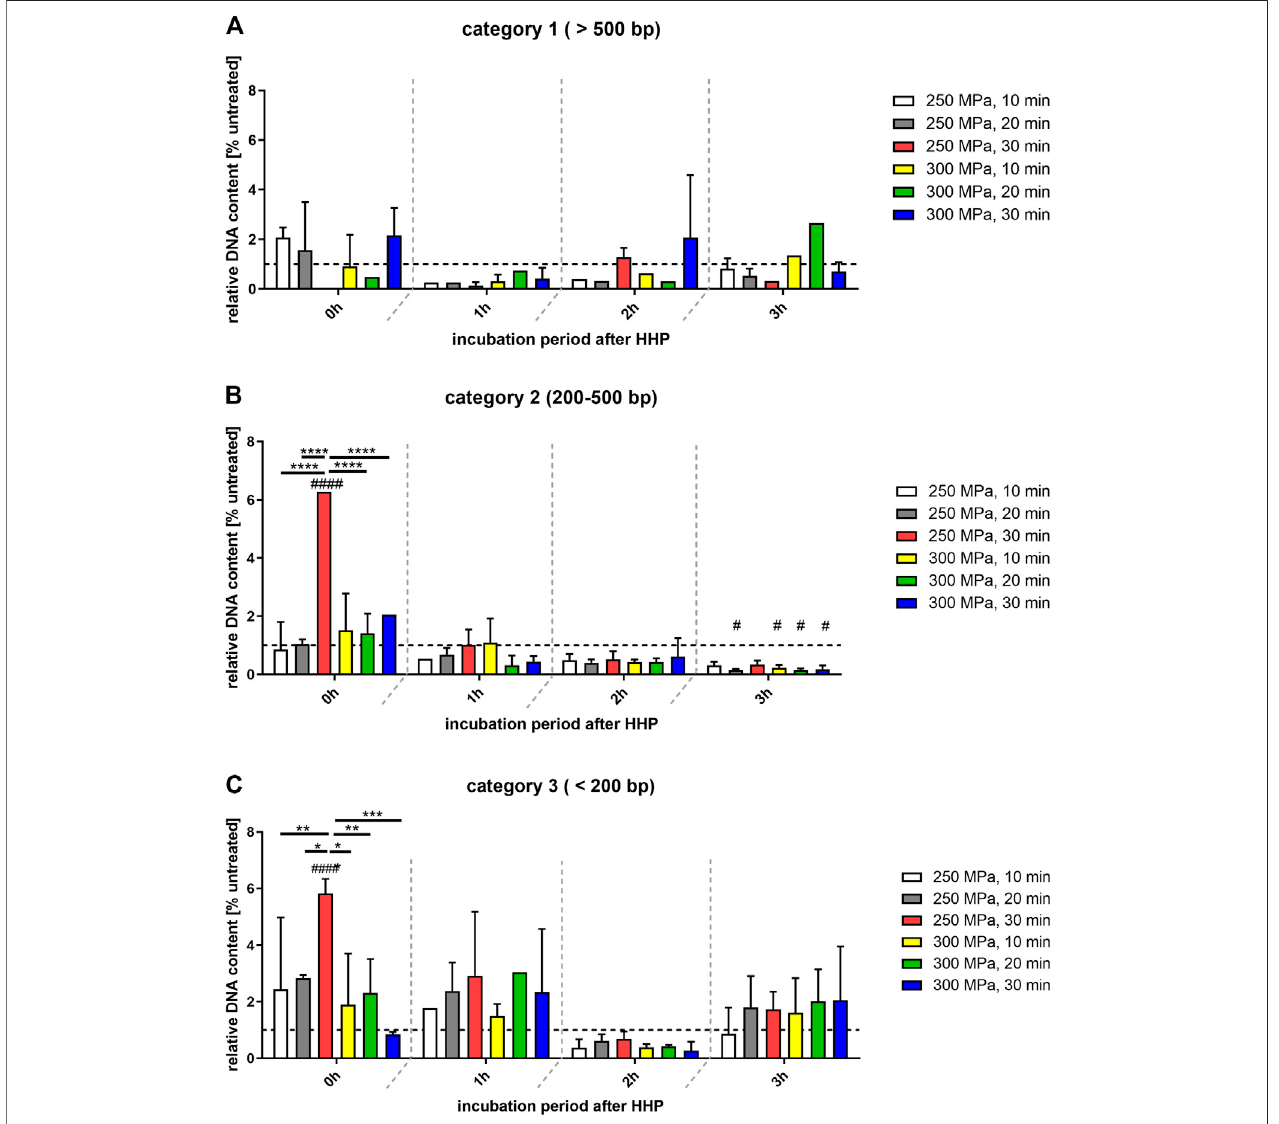
FIGURE 3 | Relative quanti fi cation of DNA-content of different fragment categories related to the control group (100%; shown as broken line). (A) Category 1: > 500 bp; (B) category2:200 – 500 bp; (C) category3: < 200 bp.Datashownasmean ± SDof7independentdonors.Statisticalanalysiswasperformedusingtwo-way- ANOVAwithBonferroni ’ smultiplecomparisontestasposthoctest.Signi fi cantlydifferentfromuntreatedcontrol:# p ≤ 0.05;#### p ≤ 0.0001.Blackbarsshowsigni fi cant differences between the different treatments within the same incubation period. * p ≤ 0.05; ** p ≤ 0.01; *** p ≤ 0.001; **** p ≤ 0.0001.